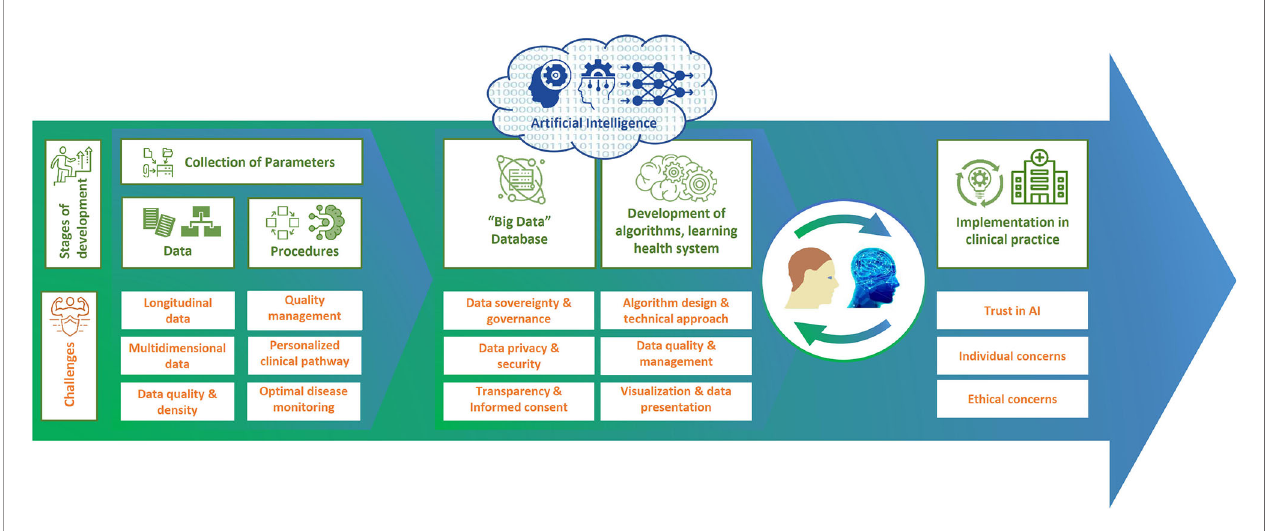
FIGURE 3 | Time fl ow for digital